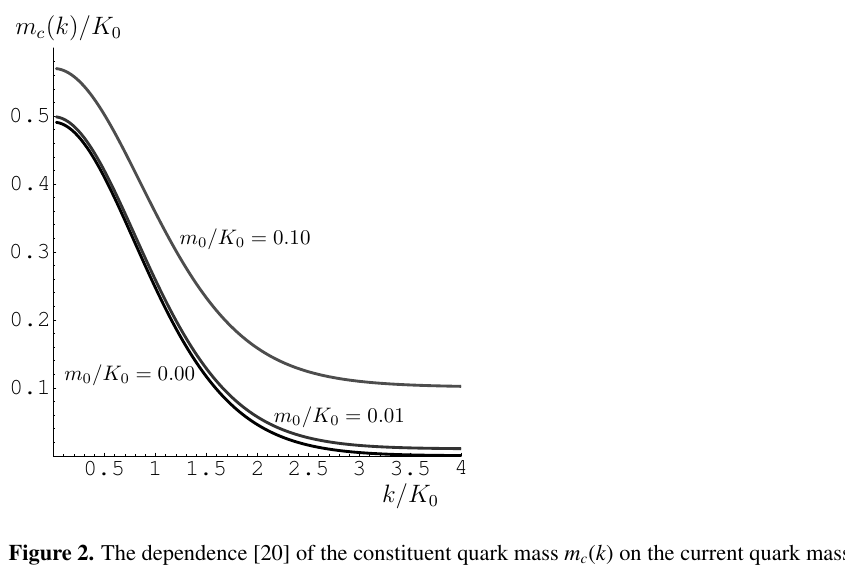
The mass gap equation for the vacua has similarities with the Bethe Salpeter equation for Hadrons in the true vacuum, who also have an infinite tower of excited states. This is a robust evidence for the